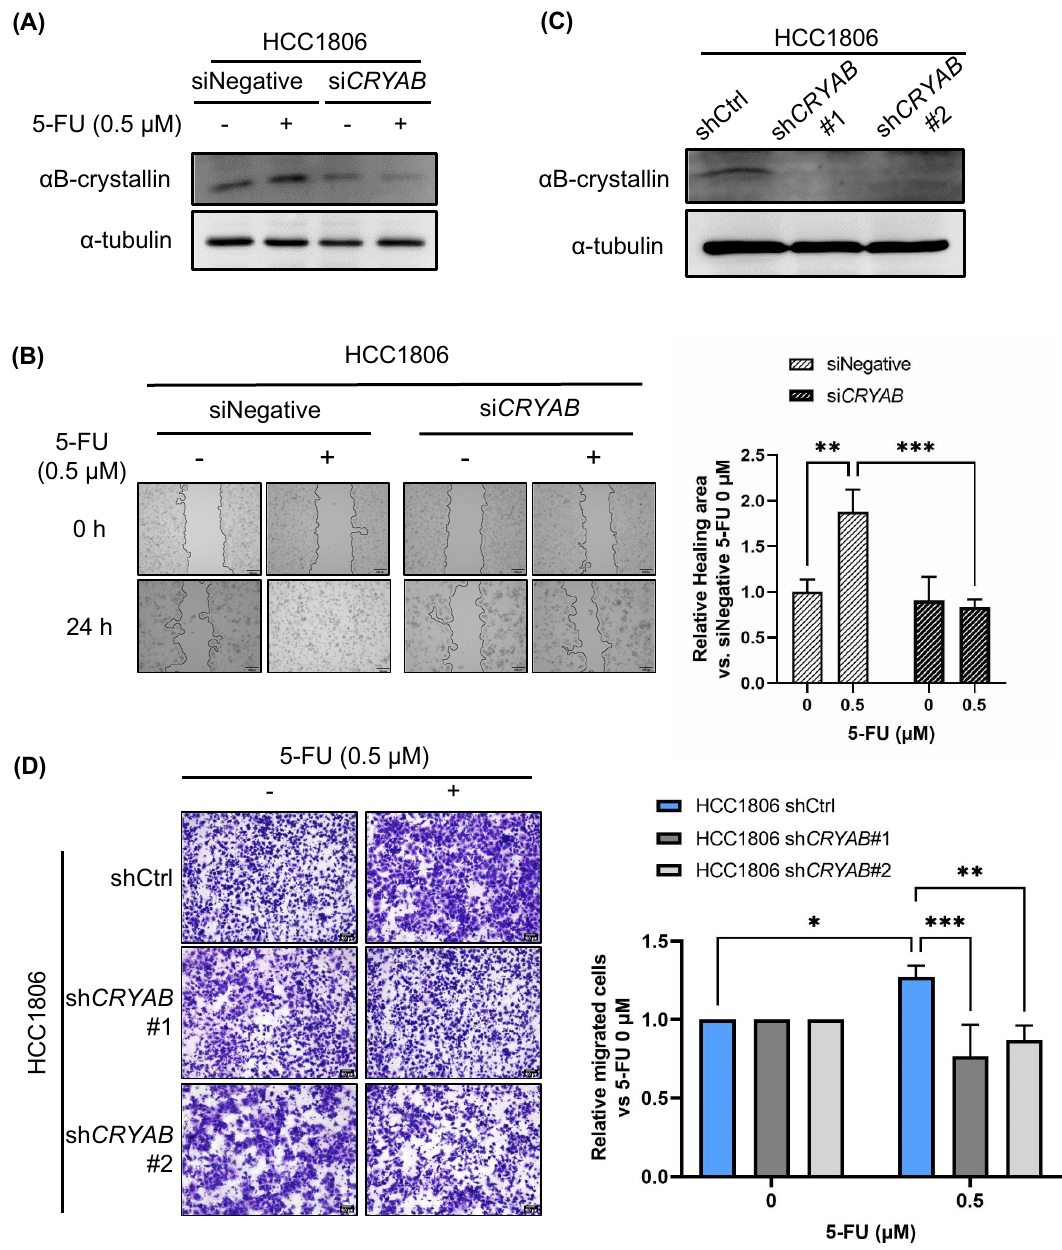
Figure 2. Silencing of αB-crystallin expression suppressed fluorouracil (5-FU)—induced increase of cell motility in HCC1806 cells. ( A ) HCC1806 cells were transfected with 10 nM of siRNA for 48 h and then treated with 0.5 μM 5-FU for 24 h. The protein expression level of αB-crystallin was evaluated by immunoblotting analysis. α-tubulin was used as the loading control. ( B ) HCC1806 cells were transfected with siRNA for 24 h and then treated with 0.5 μM 5-FU for 24 h. Images of the wound area at the beginning and end of the treatment period were recorded, and ImageJ software was used to calculate the relative healing area. siNegative: negative control siRNA; si CRYAB : siRNA targeting CRYAB. Scale bars = 100 μm. Data are presented as mean ± SD; n = 3. ** P < 0.01; *** P < 0.001. ( C ) HCC1806 cells were infected with sh CRYAB by using a lentivirus and selected by puromycin. Stable cell lines harboring the negative control vector (shCtrl) or sh CRYAB (#1 or #2) were established. The protein expression level of αB-crystallin was evaluated by immunoblotting analysis; α-tubulin was used as the loading control. ( D ) Cells were treated or not with 0.5 μM 5-FU for 24 h and then added into Transwell inserts. The number of cells that had moved through the membrane was determined by using ImageJ software. shCtrl: negative control shRNA. Scale bars = 100 μm. Data are presented as mean ± SD; n = 3. * P < 0.05; ** P < 0.01; *** P < 0.001. Results are representative of two independent